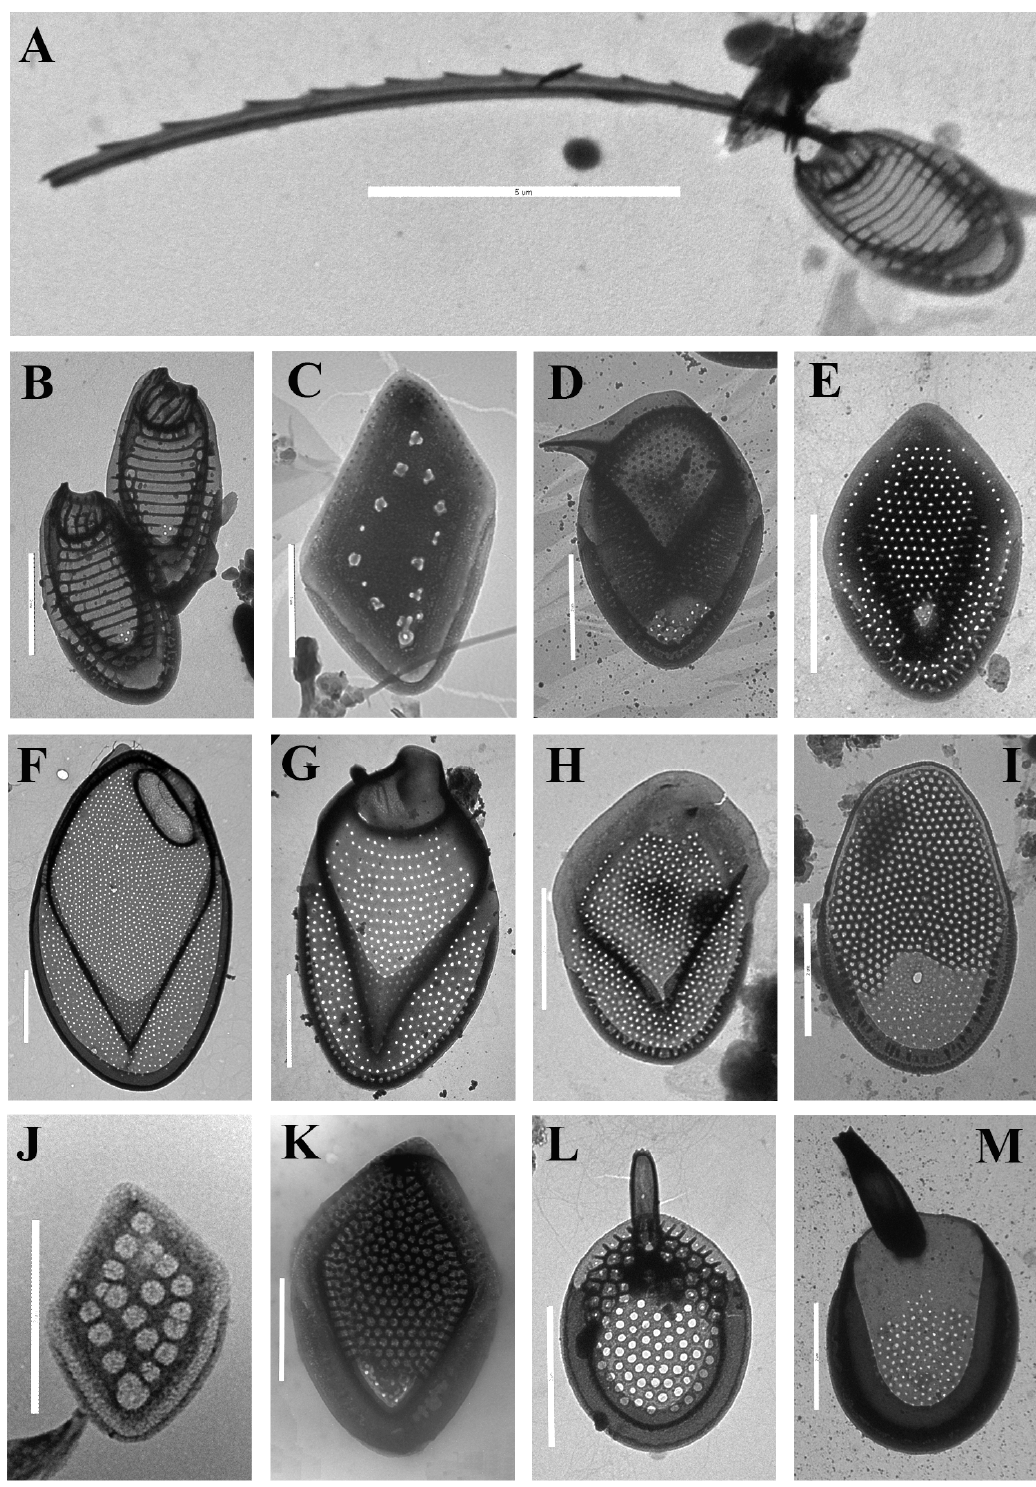
Figure 4. ( A – K ). Mallomonas ; ( L – M ). Synura . ( A , B ). Mallomonas pseudocratis . ( C ). M. siderea . ( D ). M. spinosa . ( E ). M. tonsurata . ( F ). M. vietnamica . ( G ). Mallomonas sp. 1. ( H ). Mallomonas sp. 2. ( I ). Mallomonas sp. 3. ( J ). Mallomonas sp. 4. ( K ). Mallomonas sp. 5. ( L ). Synura sp. 1. ( M ). Synura sp. 2. Scale bars: ( A ): 5 µ m; ( B – M ): 2 µ m. TEM: ( A – M ). Only four taxa ( Mallomonas kenyana (Figure 2O), M. peronoides (Figure 3L), M.